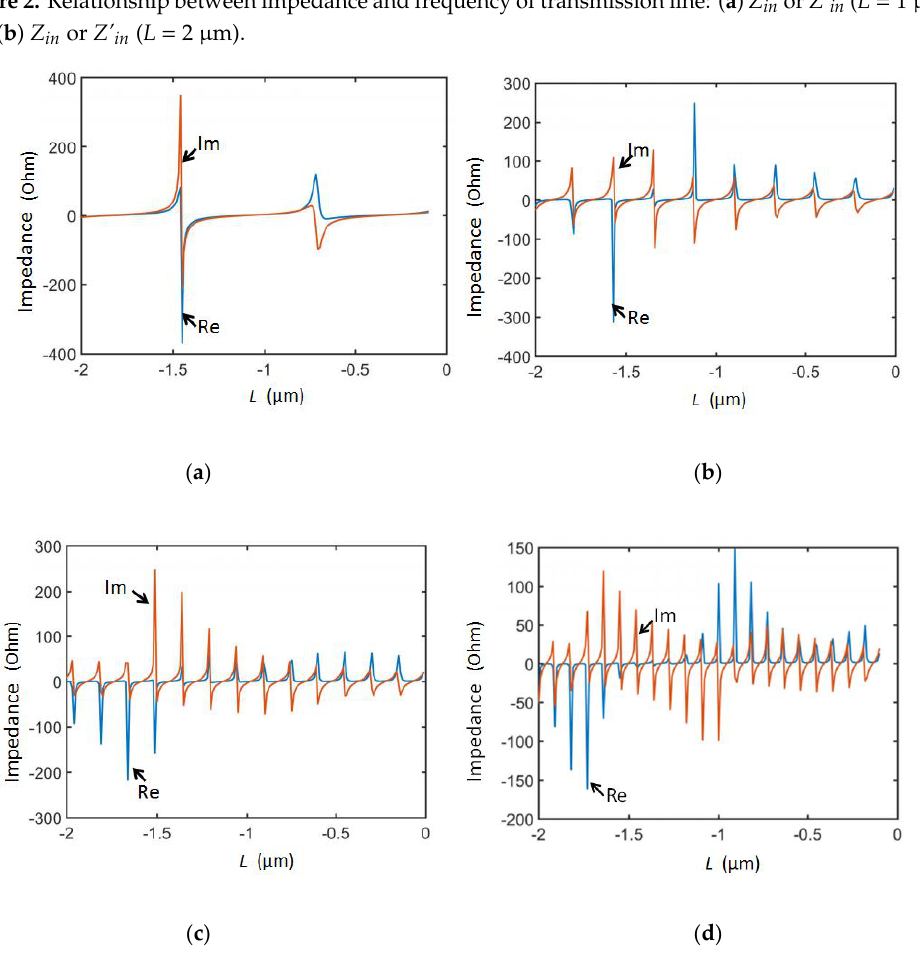
Figure 3. Relationship between impedance Z in or Z’ in and length of transmission line. ( a ) Frequency = 0.1 THz, ( b ) frequency = 1 THz, ( c ) frequency = 6 THz, and ( d ) frequency = 10 THz.